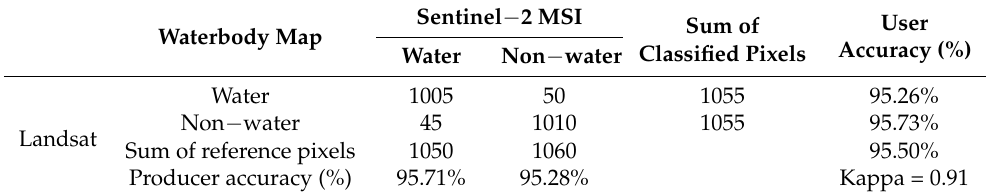
Table 1. Confusion matrix for accuracy